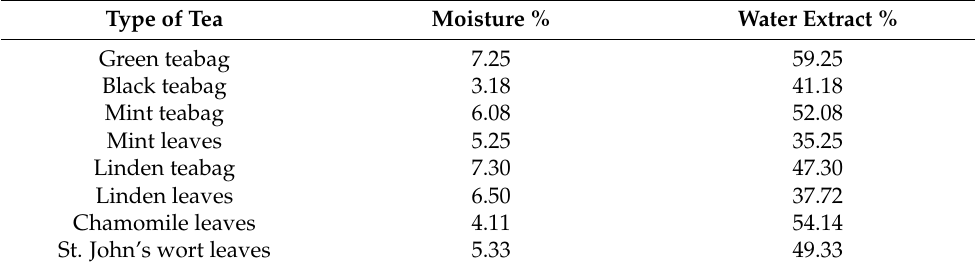
Table 1. Physicochemical analysis of tea